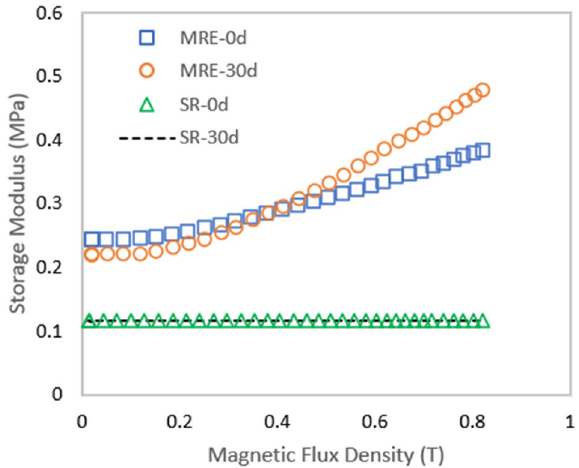
Figure 4. Storage modulus of SR and MRE samples versus magnetic flux density.